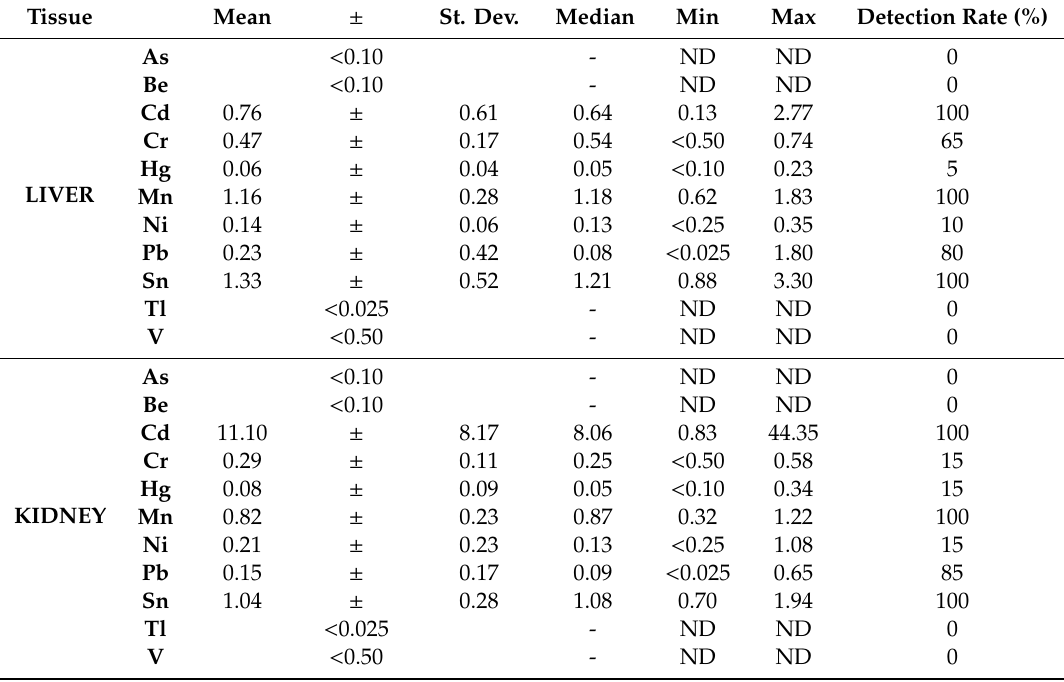
Table 1. Concentration (in µ g / g) of trace elements in samples of autopsy tissues collected in 2019 from subjects who had been living near the HWI of Constant í